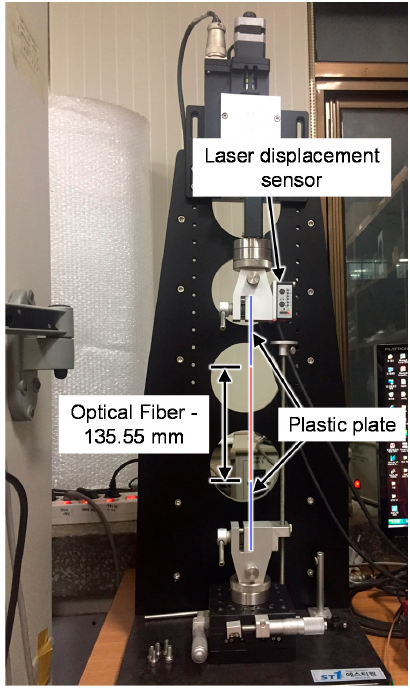
Figure 4. Tension test setup for the optical fiber.